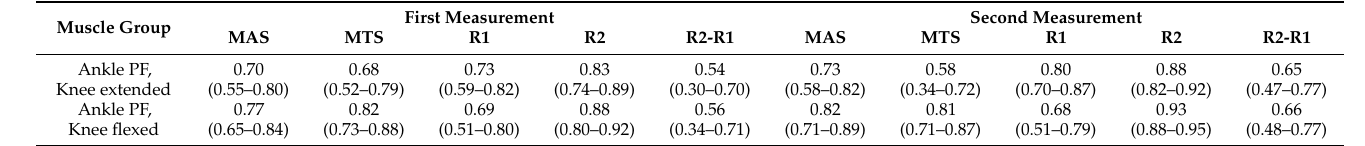
Table 2. Inter-rater reliability of the Modified Ashworth Scale and Modified Tardieu Scale for the first and second measurements.